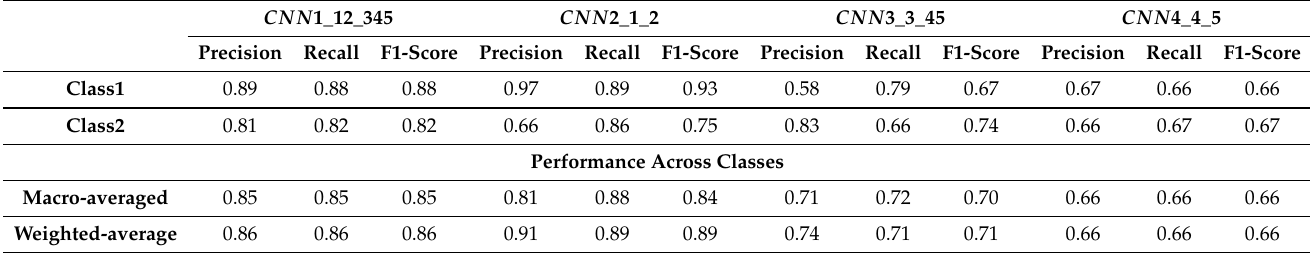
Table 2. Classification accuracy for the first level (100 × 100) of our proposed model, containing four